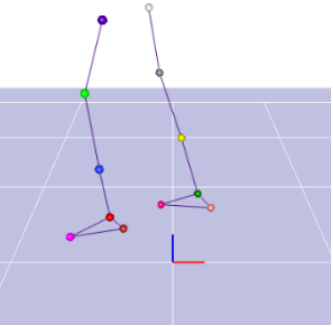
Figure 4. Gait acquisition interface.